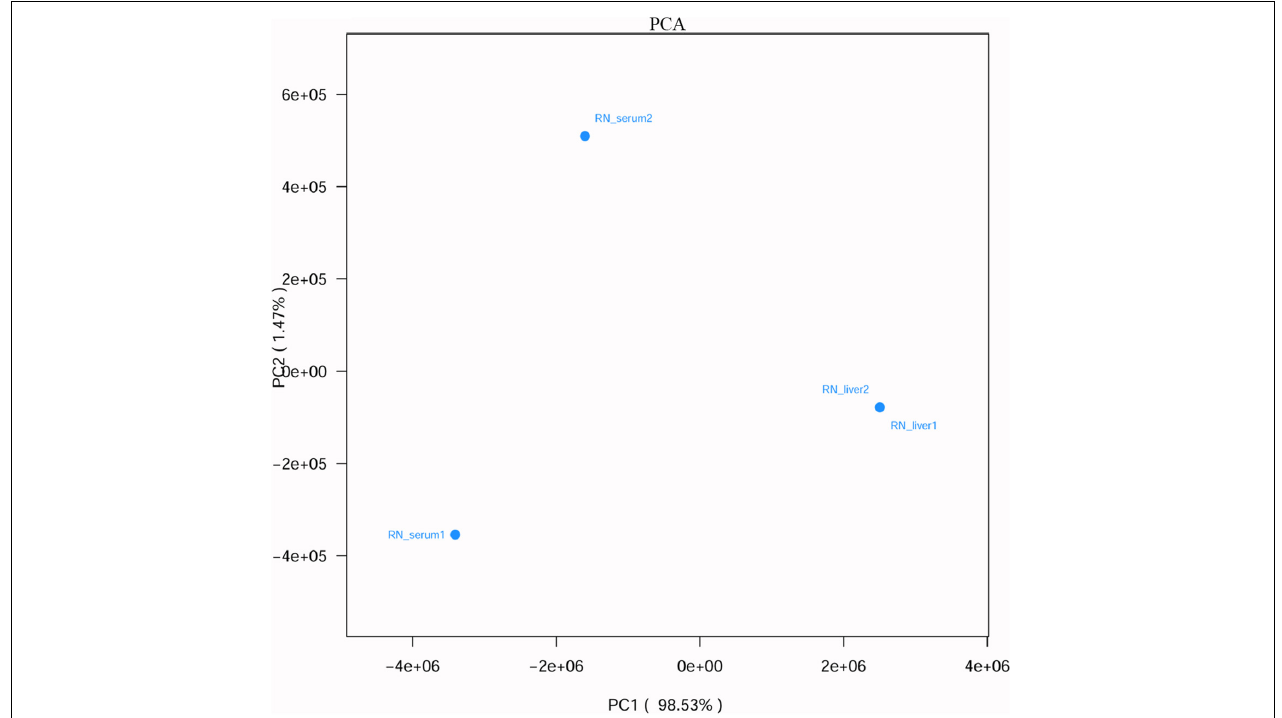
for 85.24%, 86.67%, and 74.27%, respectively, of the total number of reads. Potential viral sequences that might be